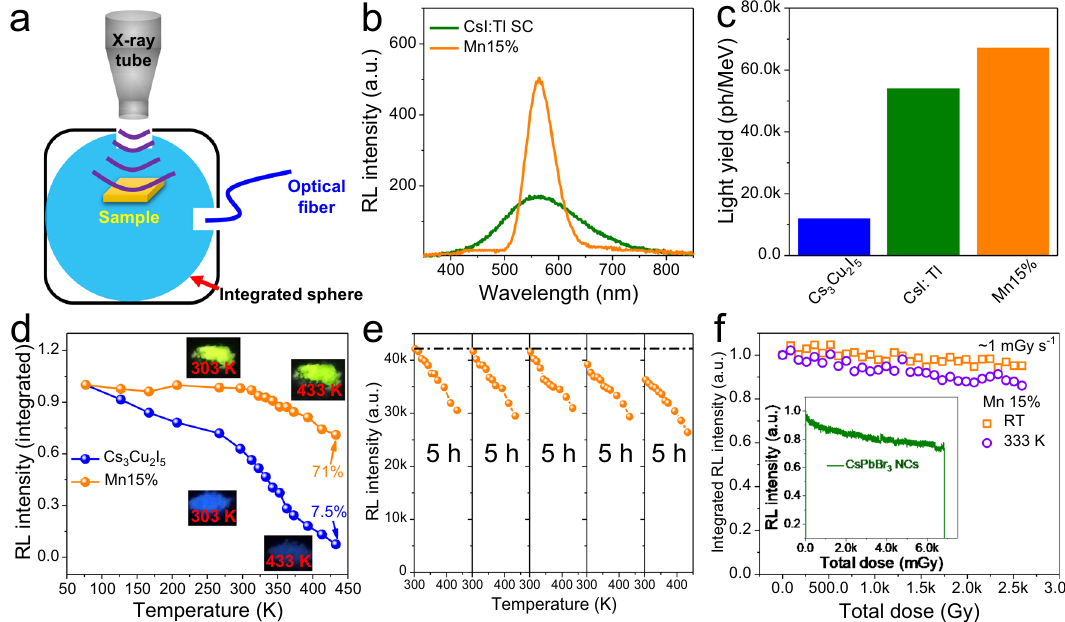
Fig. 4 Highly ef fi cient and robust scintillation properties. a Schematic of the light yield measurement system with an integrating sphere. b RL spectra of CsI:Tl single crystal and optimized Mn15%. ( c ) Comparison of light yields of CsI:Tl, Cs 3 Cu 2 I 5 and optimized Cs 3 Cu 2 I 5 :Mn. d RL intensity of Cs 3 Cu 2 I 5 and Mn15% versus temperature at an ultra-large range of 77-433 K. RL stabilities of Mn15% against e heating/cooling cycling and f long-term operation at room- and high temperature. The inset shows the stability measurement of CsPbBr 3 nanocrystals under the same dose